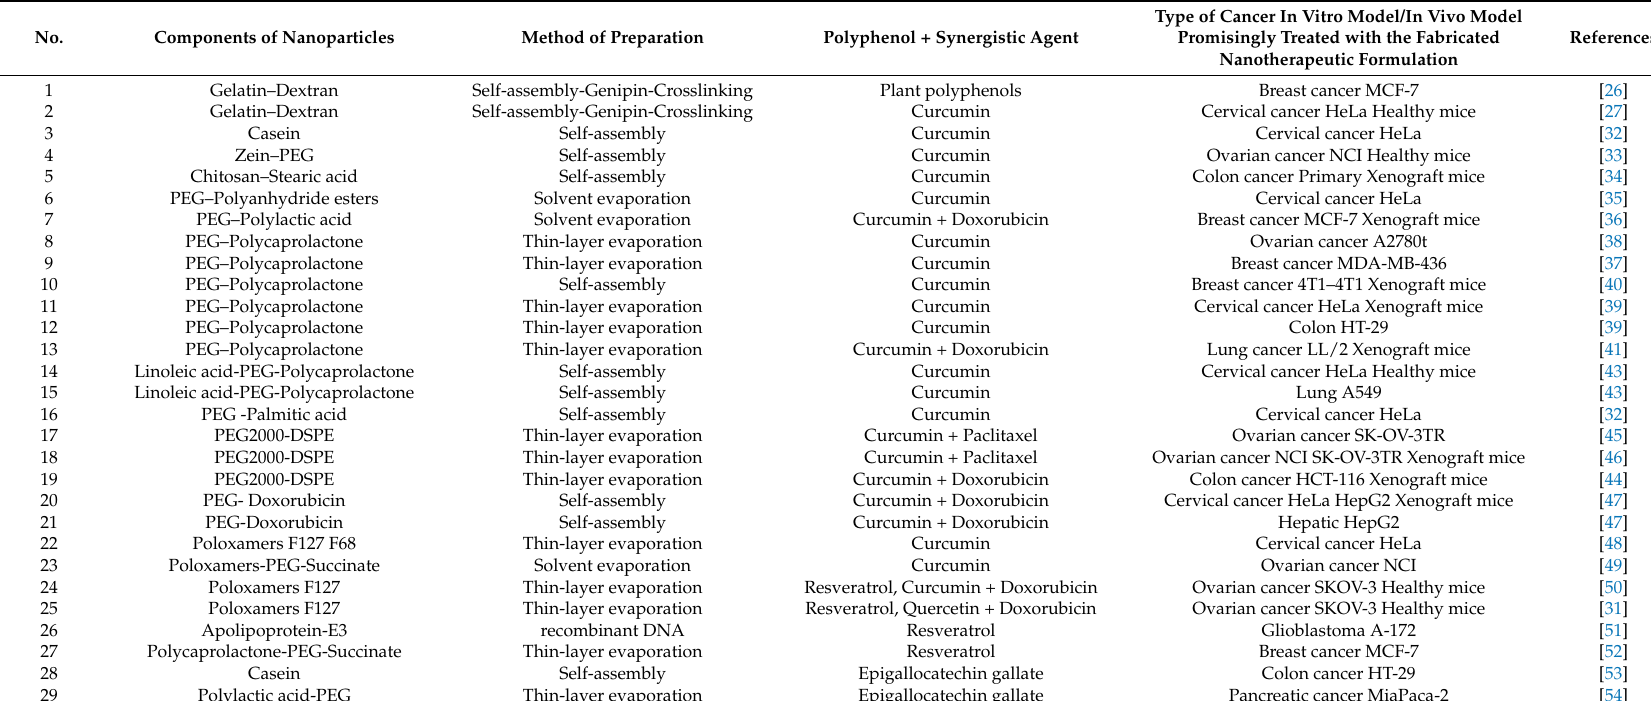
Table 2. Polyphenol-loaded polymeric micelles for the treatment of